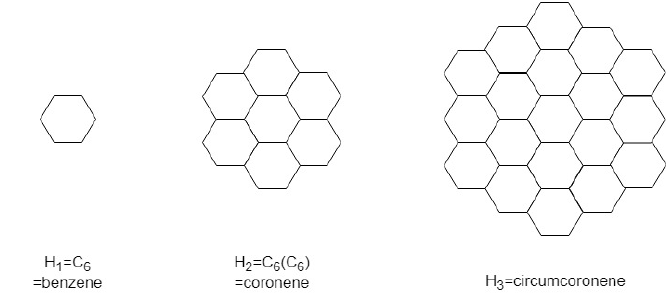
Figure 11. The first, second and third molecular graphs H 1 , H 2 and H 3 from the circumcoronene series of